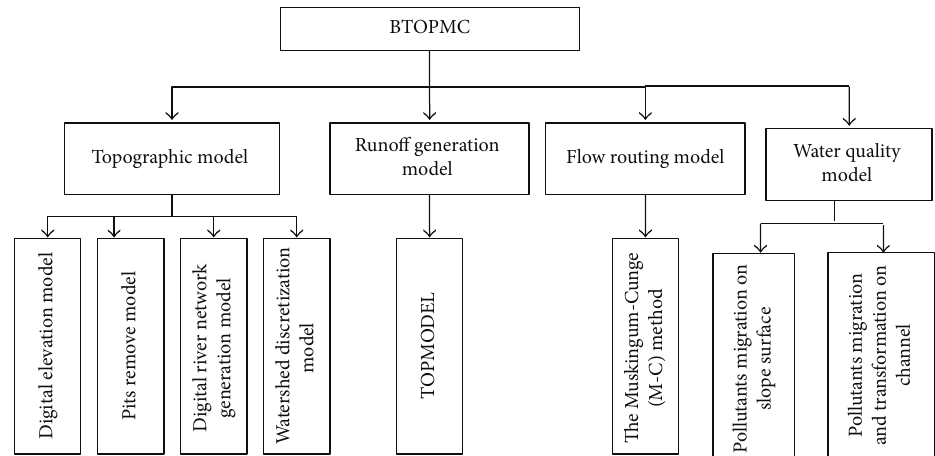
Figure 2: The main structure of